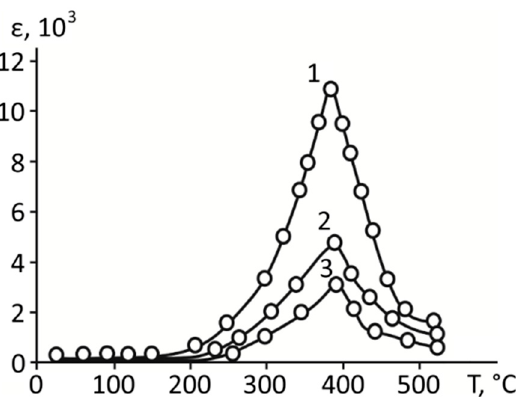
Figure 4. The dependence of dielectric permittivity on temperature for BaZrO 3 /BaTiO 3 superlattices with different frequency of measuring field: Lines 1, 2, and 3 correspond to 1 kHz, 10 kHz, and 50 kHz, respectively.